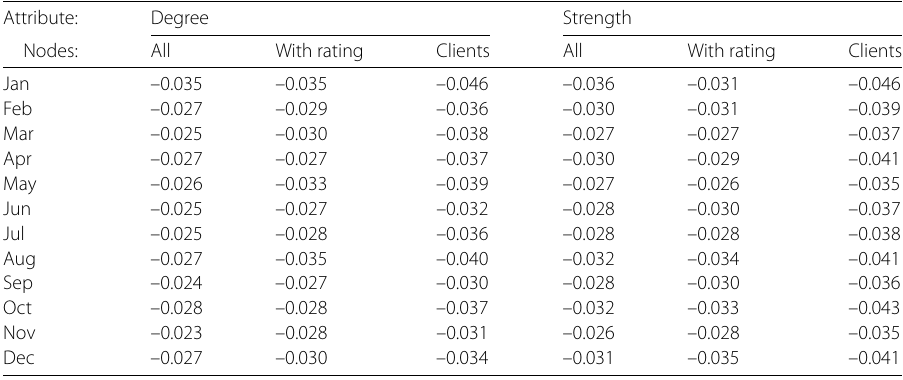
Table 8 Assortativity coefficient for degree and strength. The columns with rating refers to the subgraph of nodes with known rating. The columns customers refers to the subgraph of nodes with customer status